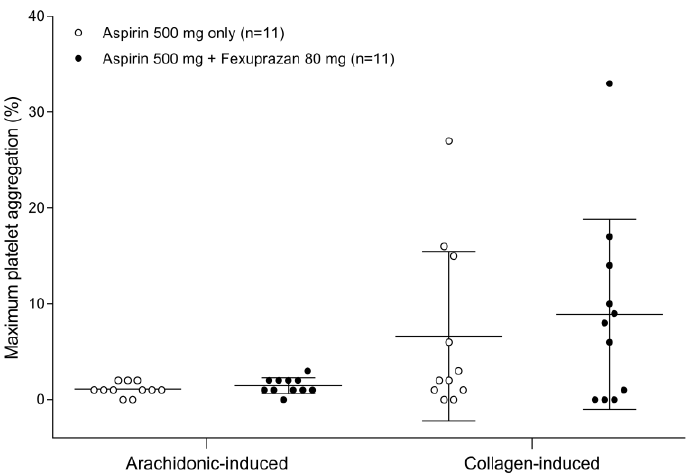
Figure 2. Maximum arachidonic acid-induced and collagen-induced platelet aggregation (%) mea- sured after a single oral administration of aspirin 500 mg alone and coadministered with fexuprazan 80 mg. The horizontal lines, vertical lines, and symbols represent the median, minimum-to-maximum, and individual data,